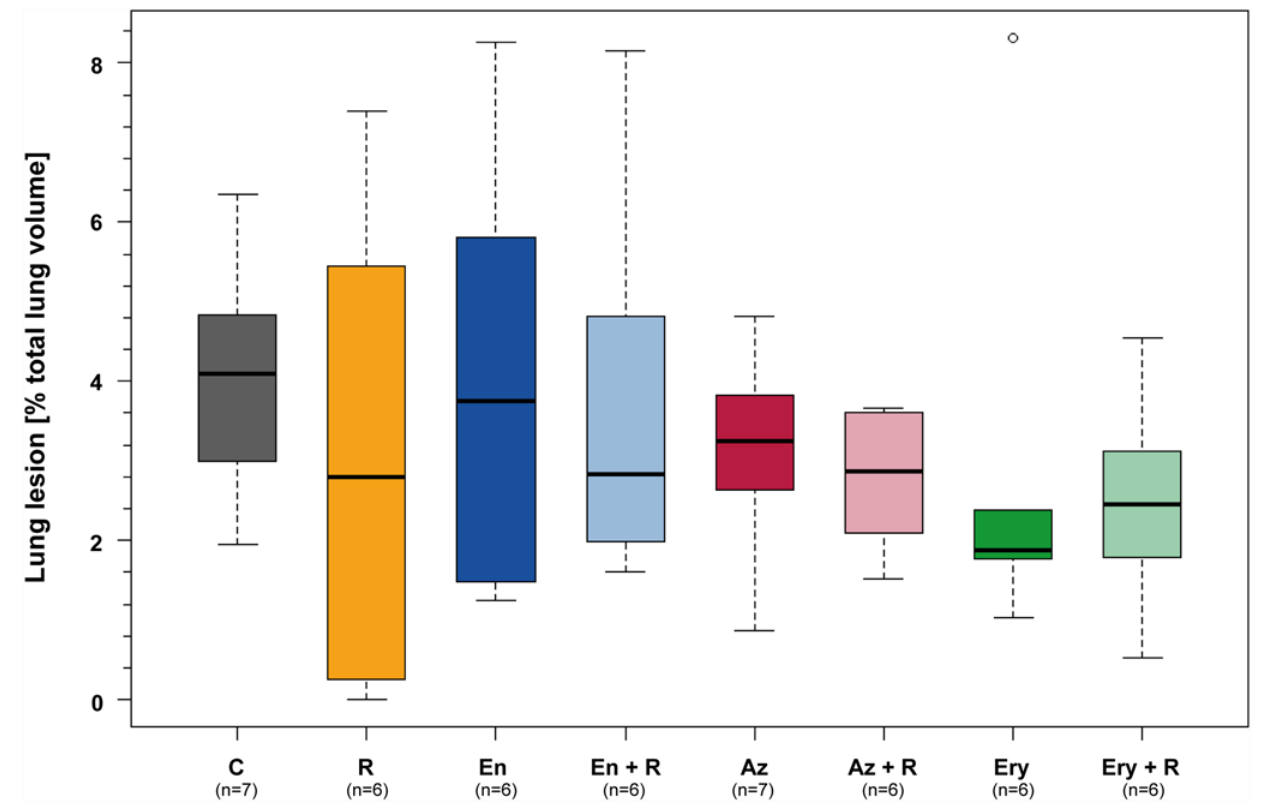
Fig 6. Percentage of altered lung tissue on total lung volume assessed 14 dpi at necropsy. The proportion of altered lung tissue 14 days after inoculation with C . psittaci did not differ between treated and untreated animals (many-to-one comparisons by Gao et al . (2008) with Hochberg-adjustment, P > 0.58). C: untreated controls, R: rifampicin, En: enrofloxacin, En + R: enrofloxacin + rifampicin, Az: azithromycin, Az + R: azithromycin + rifampicin, Ery: erythromycin, Ery + R: erythromycin + rifampicin. dpi: days post